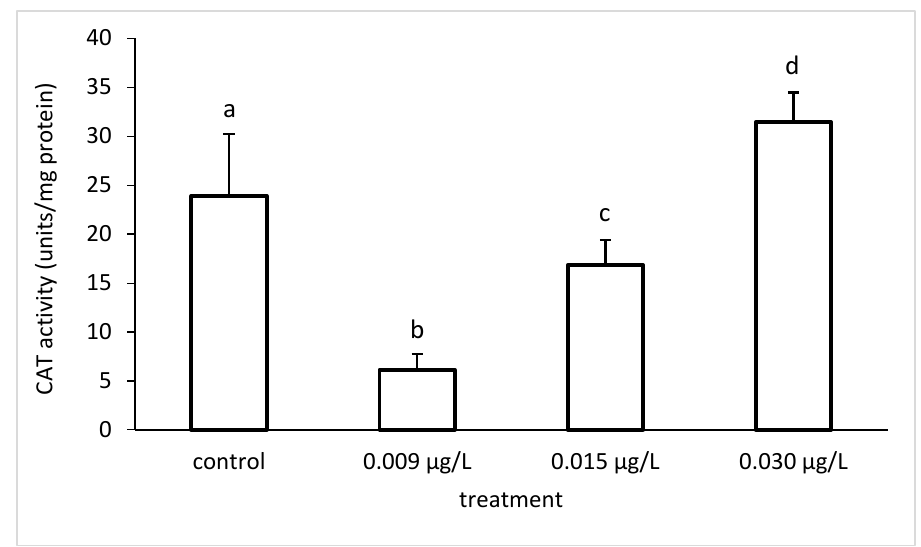
Figure 7. Catalase (CAT) activity in common carp liver under different CPF exposures. Bars represent means ± SD of the control and experimental groups. Different letters indicate significant differences among treatments ( p < 0.05).